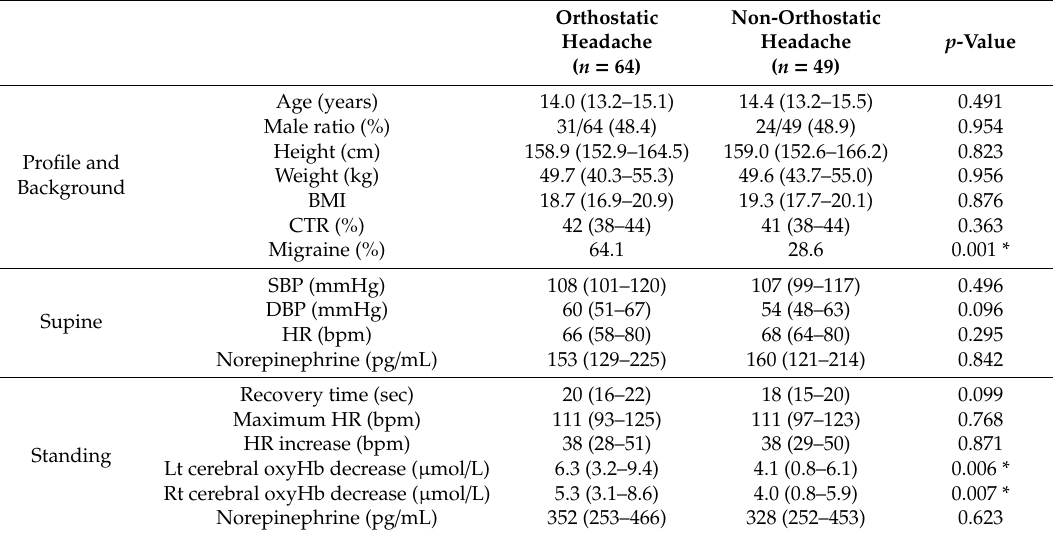
Table 1. Participant characteristics and standing test results.